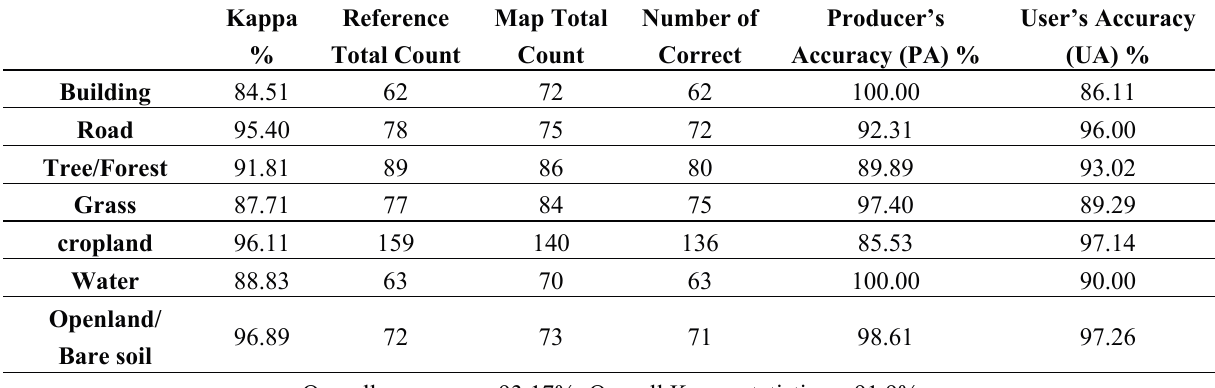
Table 5. Accuracy assessment on classification result using Object-Based Imagery Analysis (OBIA).